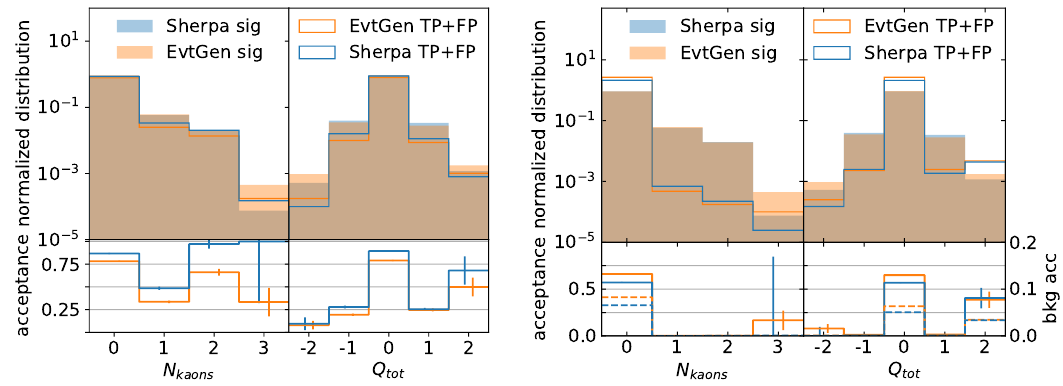
Figure 8 . Q tot and N kaons distributions and signal acceptance for NN tight (left) and NN loose (right) trained on E VT G EN data. For NN the dashed lines in the lower panels show the background loose acceptance, using the scale for the y -axis displayed on the right. In the lower panels, error bars highlight the MC uncertainty on the acceptance which for most bins (all bins for the background acceptance) is too small to be visible in the